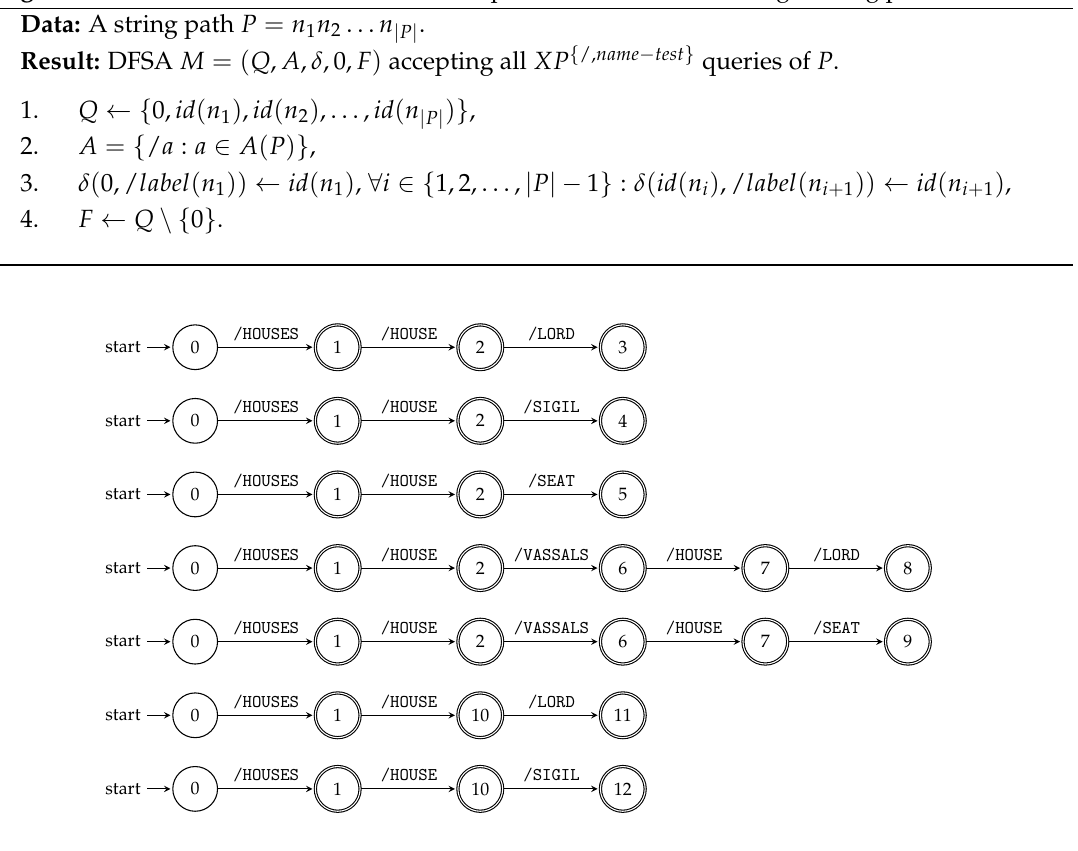
Algorithm 1: Construction of a deterministic prefix automaton for a single string path. Data: A string path P = n 1 n 2 . . . n |